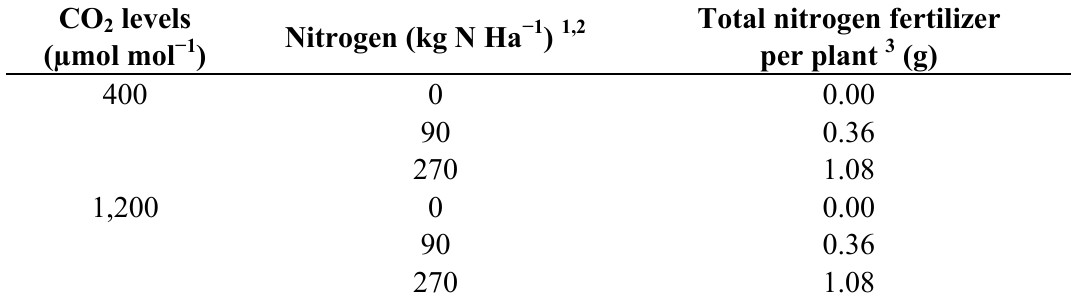
Table 5. Treatments combination of CO Labisia pumila Benth. during the